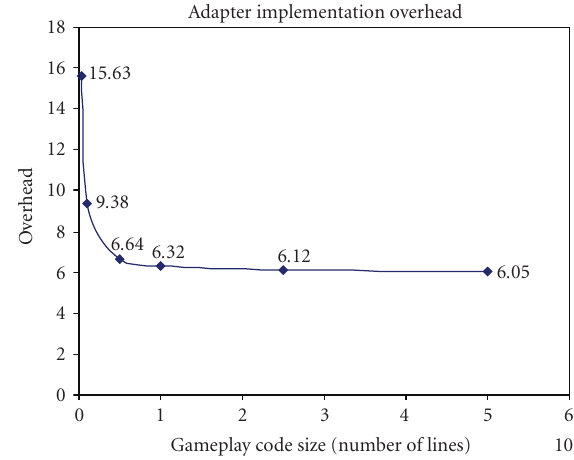
Figure 7: The adapter code forecast compared to the game logic code